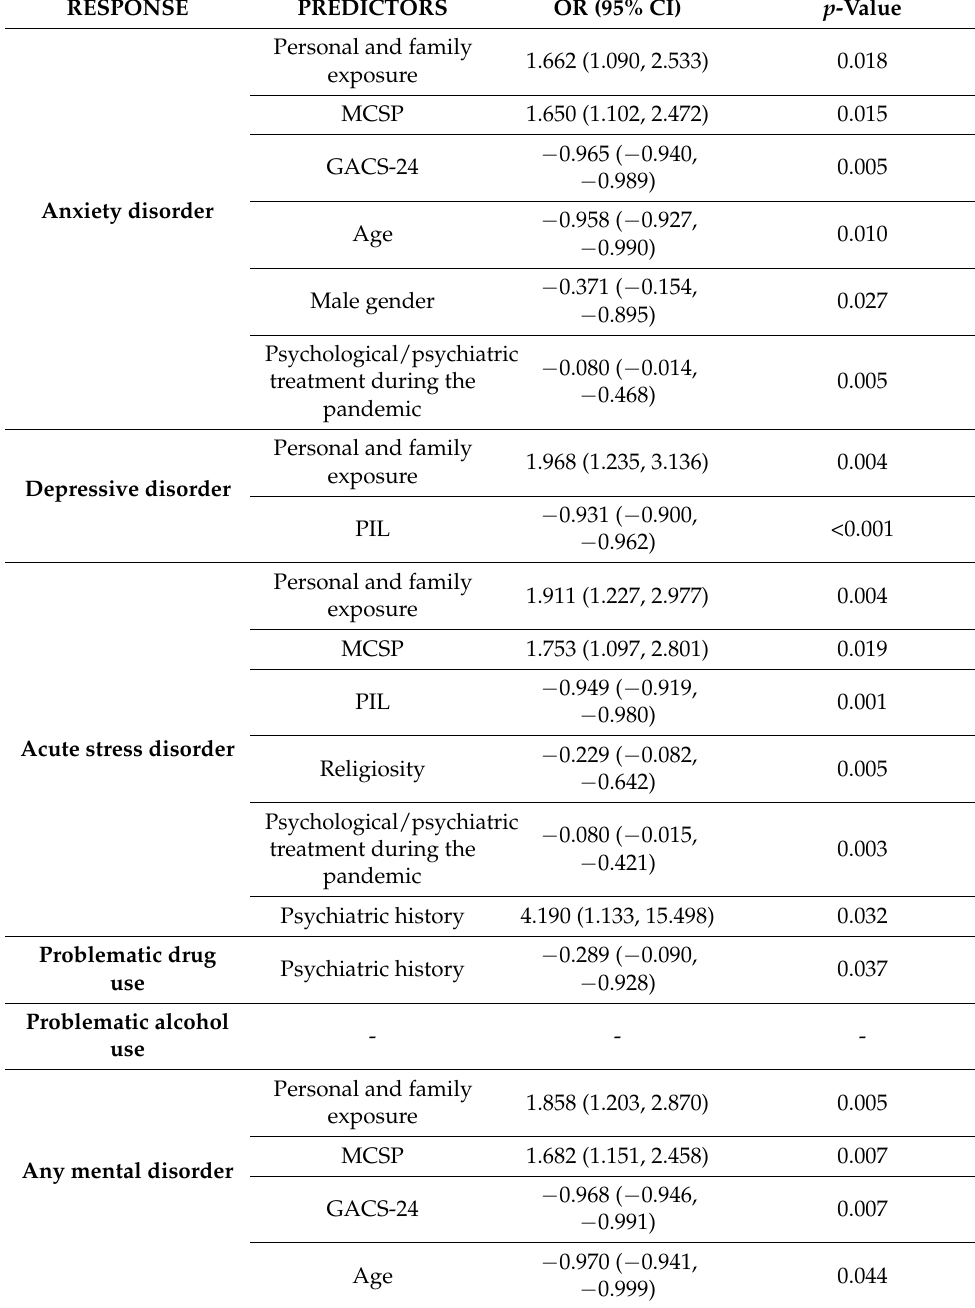
Table 4. Significant odds ratios of the logistic regression models predicting the presence of men- tal